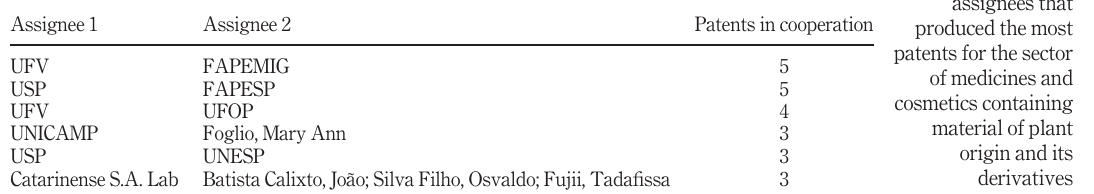
Figure 4. Collaboration network among patent assignees for the sector of medicinal